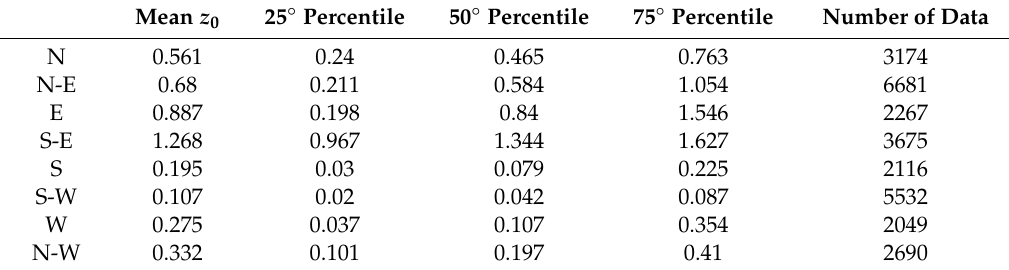
Table 9. Surface roughness z 0 for TDCs.